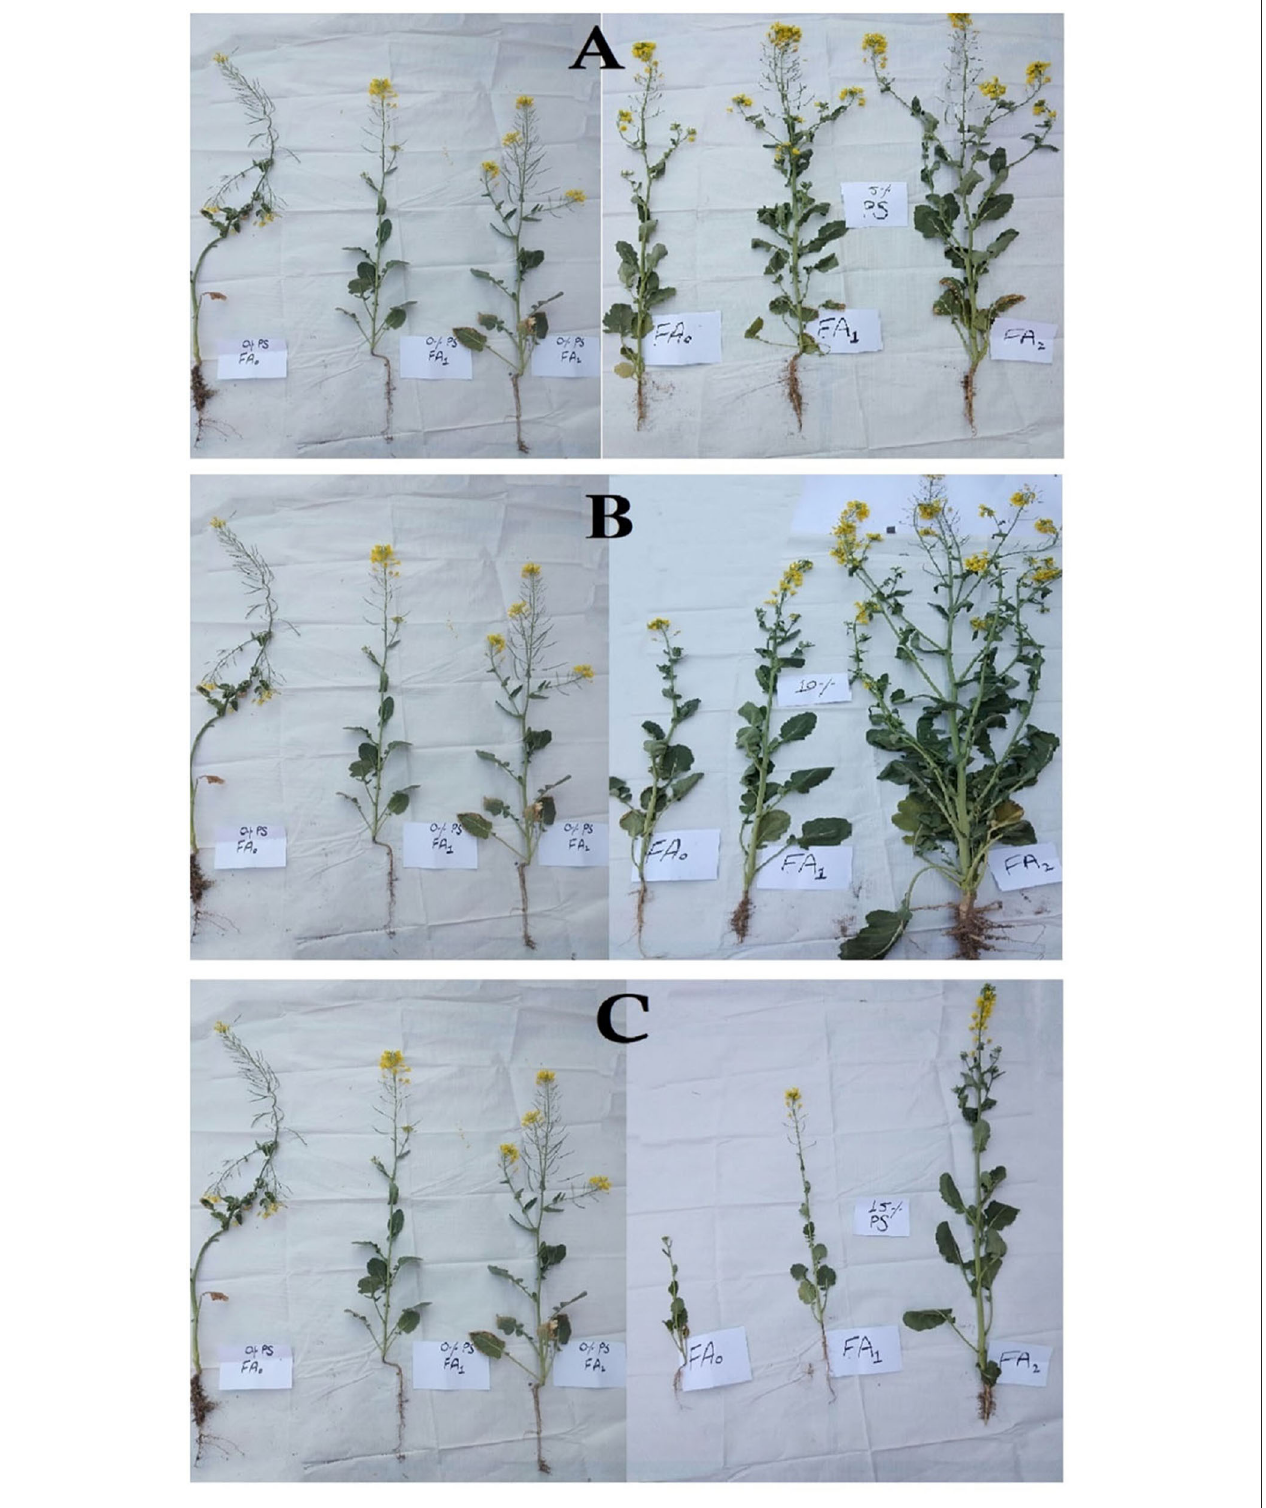
FIGURE 3 | (A) Comparison of control (0%) with 5% concentration of paper sludge. (B) Comparison of control with 10% concentration of paper sludge. (C) Comparison of control with 15% concentration of paper sludge.